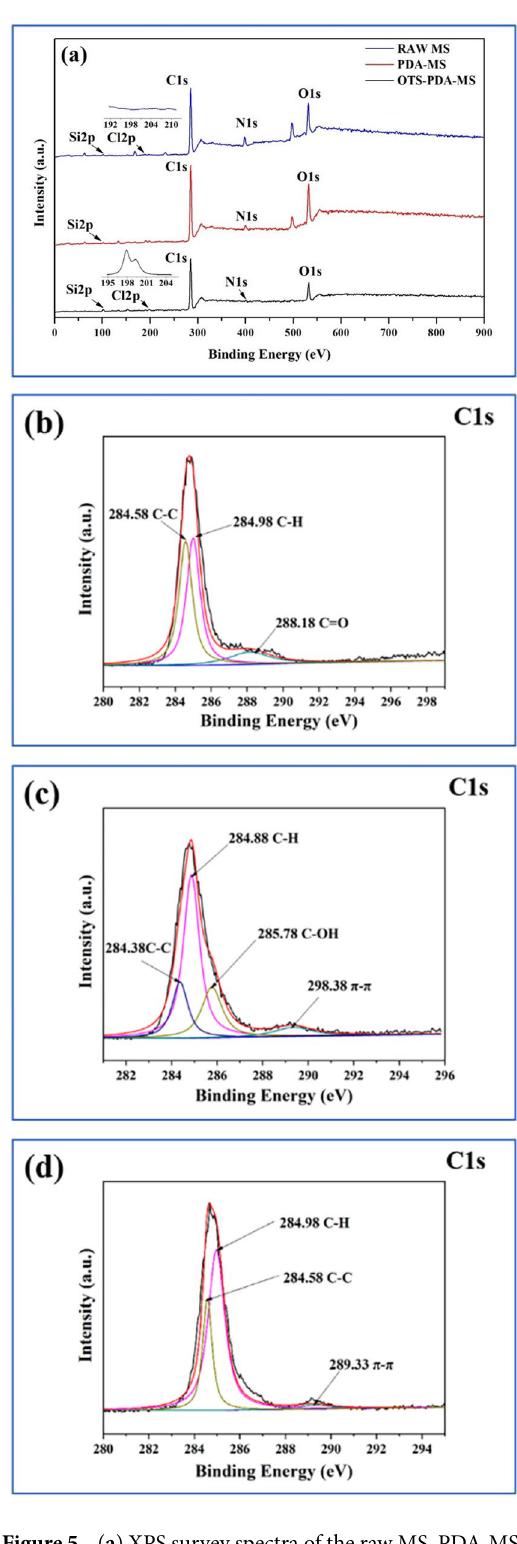
Figure 5. ( a ) XPS survey spectra of the raw MS, PDA-MS and OTS-PDA-MS; ( b – d ) are the C1 s XPS spectra of raw-MS, PDA-MS and OTS-PDA-MS,